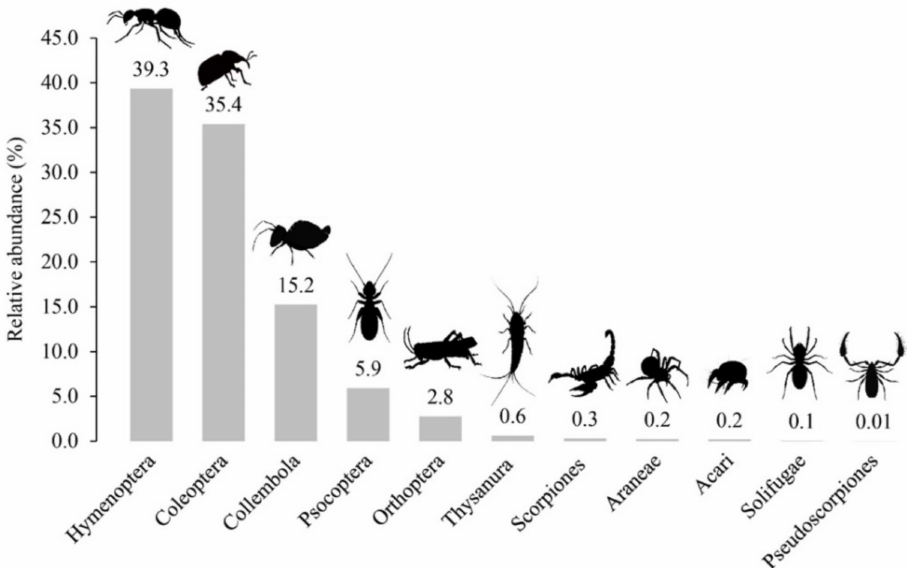
Figure 3. Relative abundance (individuals) of epigean arthropod orders registered at the Paposo- Taltal section (Antofagasta Region, Chile).